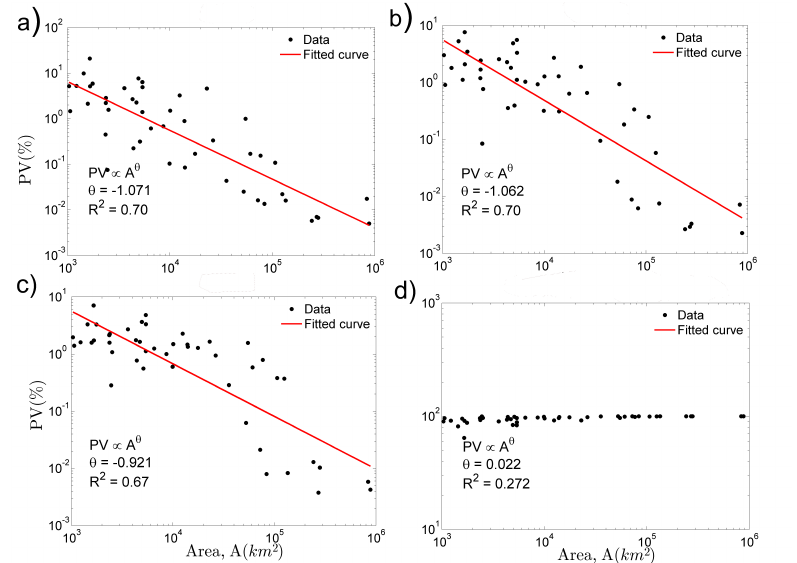
Figure 6. Percentage of total variance explained by the modes of synoptic variability for streamflows versus the area of the river basins. ( a ) IMF1; ( b ) IMF2; ( c ) IMF3; ( d ) variance explained by the other frequency